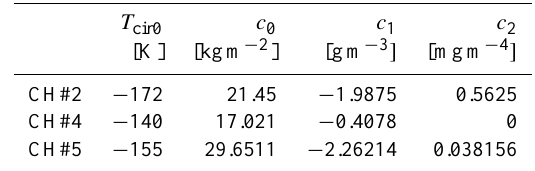
Table 1. Look-up table for the parameters of the joint IWP – h t re-